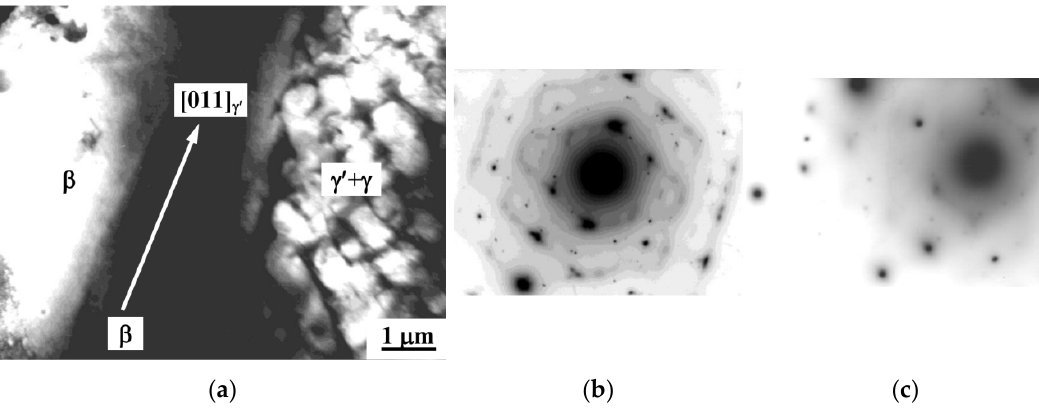
Figure 4. Electron microscopic image of the fine structure in the sample after DC: ( a ) junction of structural phase states “A” ( γ′ + γ ) and “B” ( β ); ( b ) microdiffraction pattern obtained from state “B” (there are only reflections of the β -phase); ( c ) microdiffraction pattern obtained from state “A” (only reflections of the γ -/ γ′ -mixture are present).